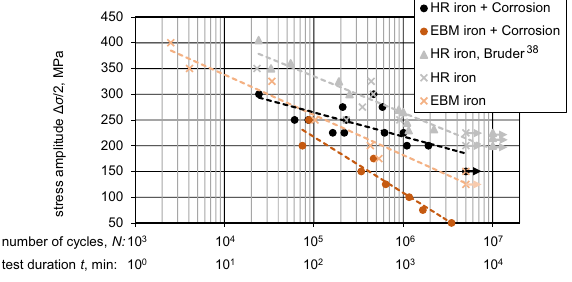
Fig. 14 S – N -curves obtained from corrosion fatigue tests con- ducted in m-SBF. Both material states are shown in comparison with fatigue tests under purely mechanical load (cf. Fig.